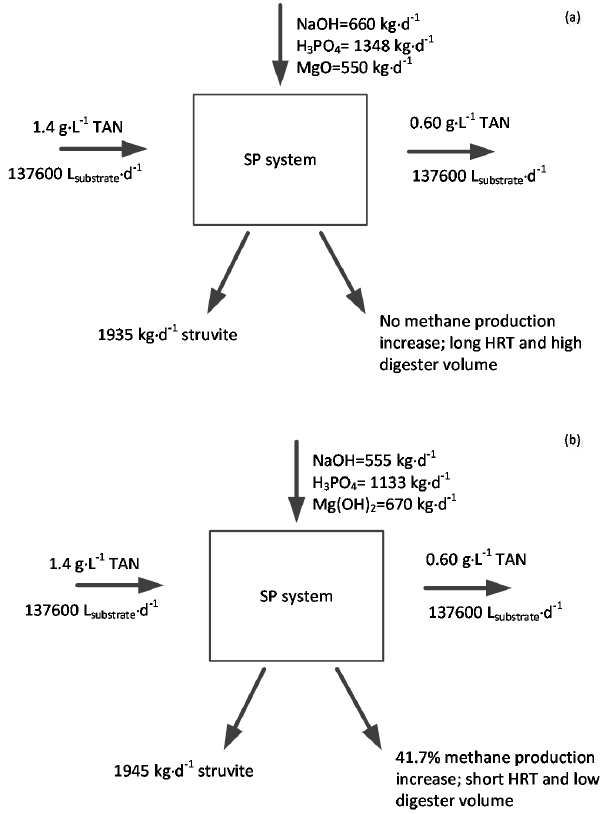
Figure 3. Simplified diagram for the calculation of economic benefits of SP using MgO ( a ) and Mg(OH) 2 ( b ) as Mg source.